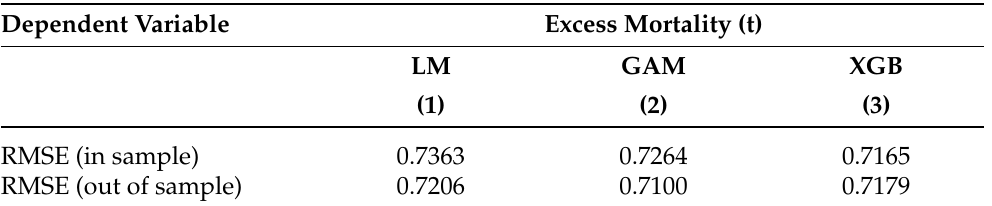
Figure 6. XGB Tuning Selections. Table 3. Excess Mortality fit using XGB compared with LM and GAM—in-sample and out of sample